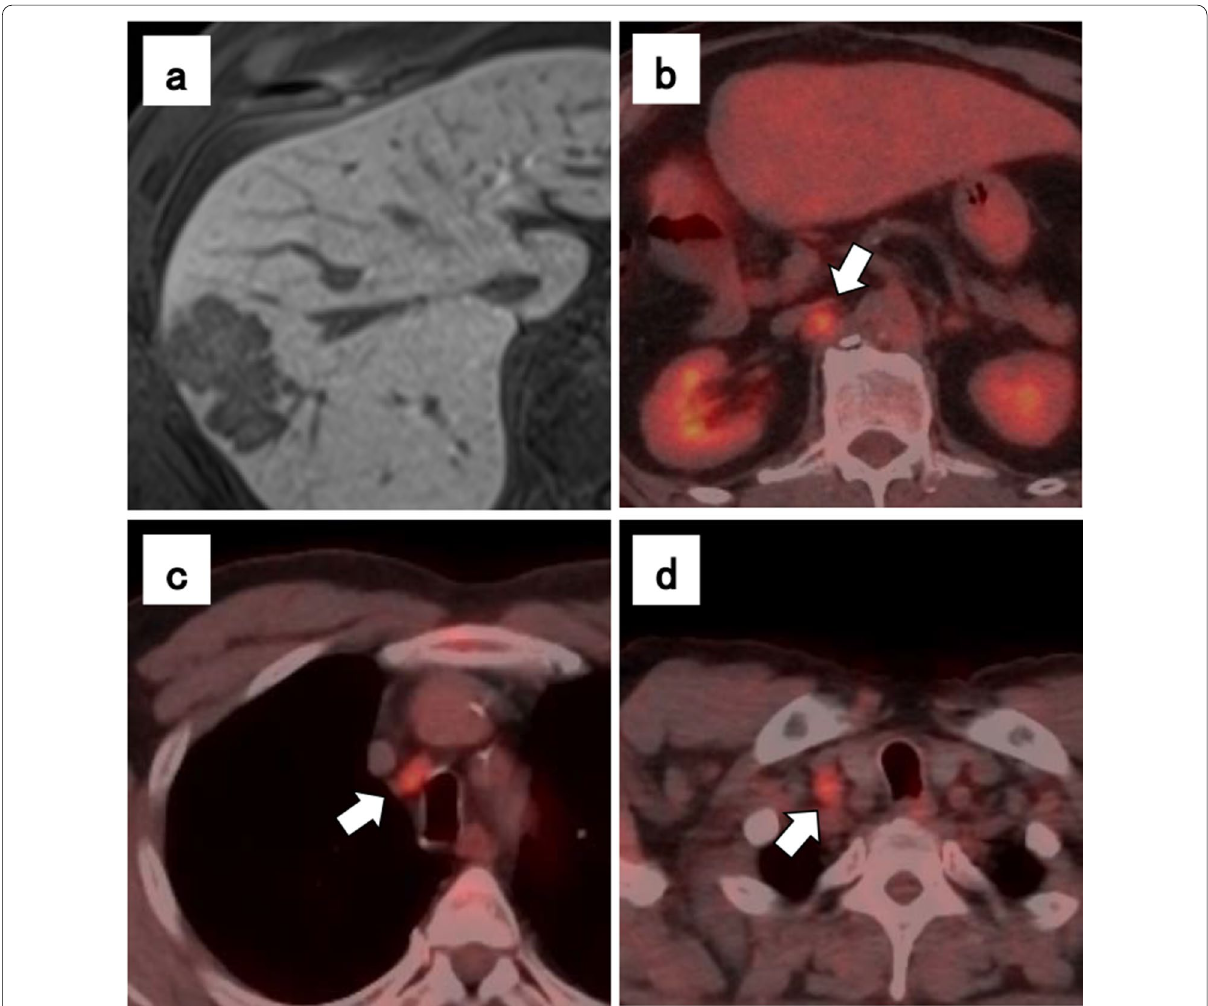
Fig. 1 Hepatocellular carcinoma findings on magnetic resonance imaging, and lymph node metastasis on positron emission tomography– computed tomography (PET–CT) imaging. The tumor was located at the border of segments 8 and 7 of the liver ( a ). Lymph node metastasis seen on PET–CT, a subdiaphragmatic lymph node ( b ), an upper mediastinal lymph node ( c ), and a right cervical lymph node ( d